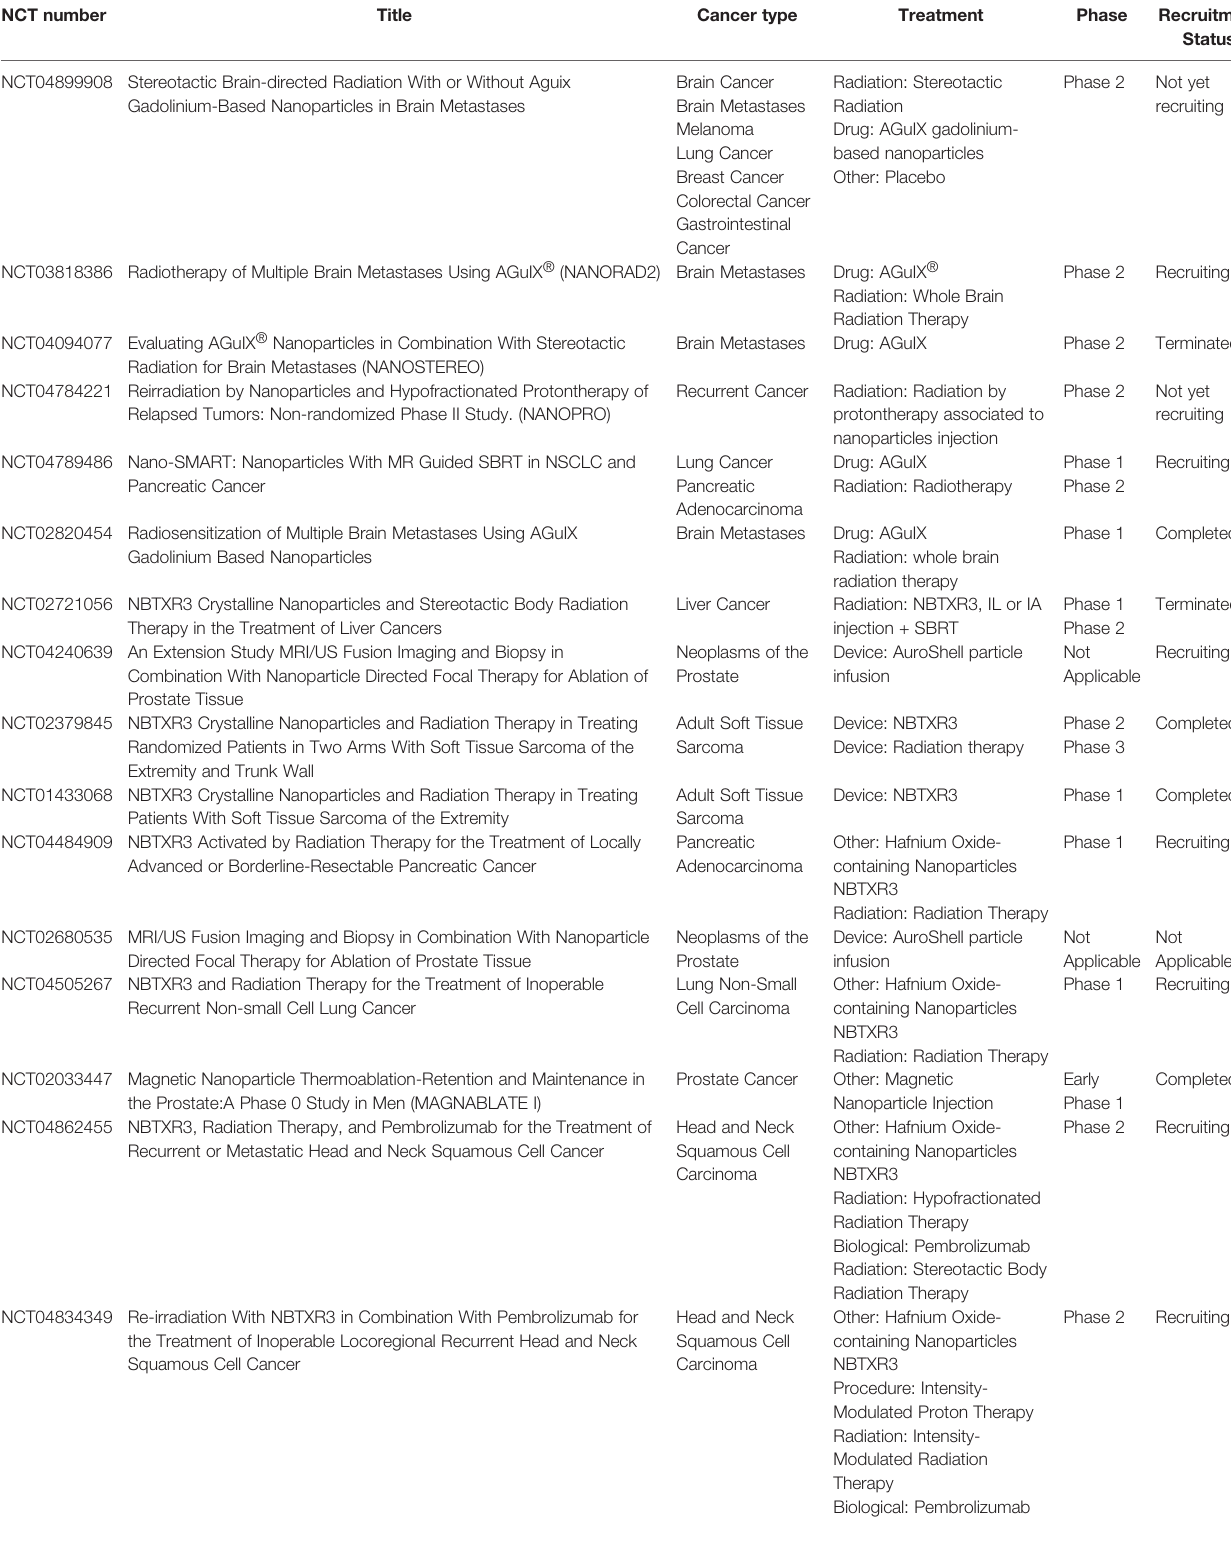
TABLE 3 | Clinical trials about radiosensitizers based on